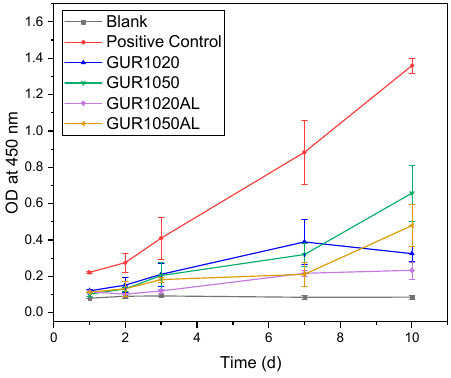
Figure 10. WST test overview, N = 15.